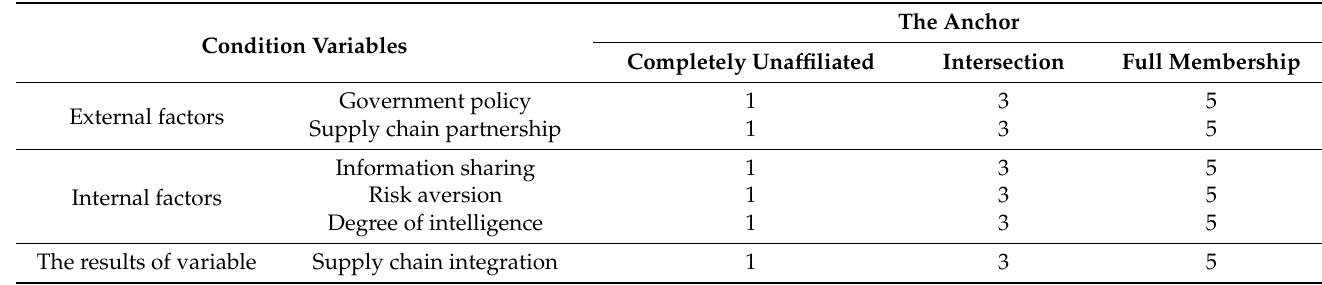
Table 4. Variable calibration anchor points.